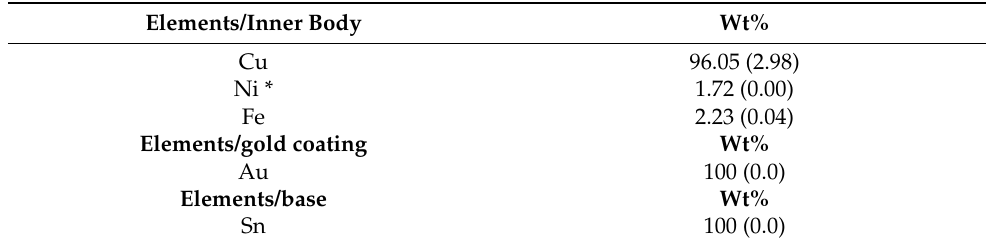
Figure 2. Scanning electron micrographs of: ( a ) inner body and base of a pin at 40 × and 500 × magnification, respectively; ( b ) inner body at 500 × magnification ( c ) elemental maps of a section close to the coating inside the inner body of the pin; and ( d ) elemental map of the gold coating. The white box on the right indicates the area where elemental mapping was performed, and the box on the left shows where the chemical analysis of the base was performed. Table 1. Chemical composition of the single pin by EDS analysis of the inner body, gold coating and base. Standard deviation is shown in parentheses.